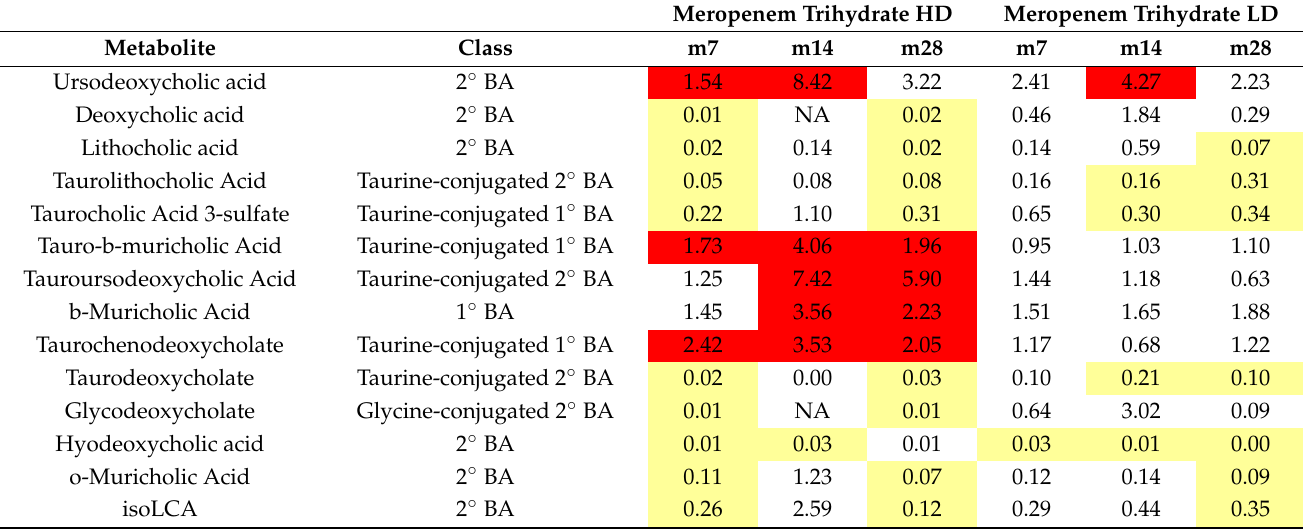
Table 9. Meropenem-induced blood plasma BA fold changes in male (m) Wistar rats. Metabolite fold changes in plasma BAs of male Wistar rats (N = 5 per group) dosed with meropenem (100 (LD) and 300 (HD) mg/kg bw/day) observed on 7, 14, and 28 days (m7, m14, and m28). Statistically significant changes (Welch t -test; p -value < 0.05) are shown where red boxes mean a significant increase in the respective plasma BAs and yellow boxes mean a significant reduction compared to control